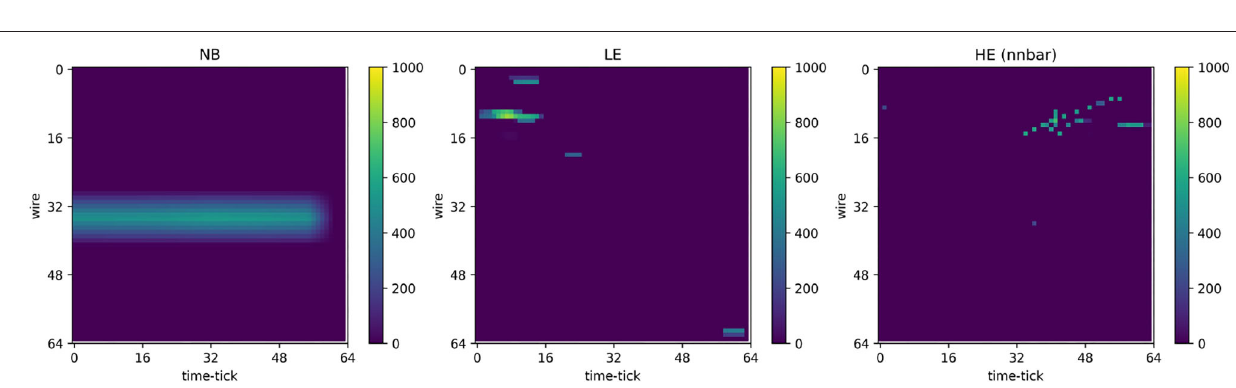
FIGURE 3 | Example ROIs formed after pre-processing. Left : Image containing electronics noise and radiological background only (NB). Middle : Image containing one low-energy supernova neutrino interaction (LE) superimposed with electronics noise and radiological background. Right : Image containing one high-energy interaction (HE), specifically from neutron-antineutron oscillation (nnbar), superimposed with electronics noise and radiological background. The color z axis indicates ADC values after down- or up-sampling. These images are renormalized with pixel values ranging from 0 to 1 prior to inputting to a CNN for subsequent processing (data